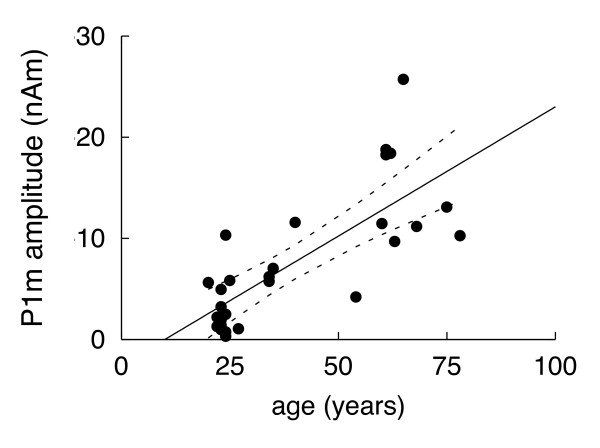
P1m amplitude as a function of age. P1m amplitudes are significantly larger in older than younger participants (linear regression, R2 = 0.56, F(1,26) = 32.78, p < 0.001). The black line represents the linear regression line and the dashed lines the confidence intervals.